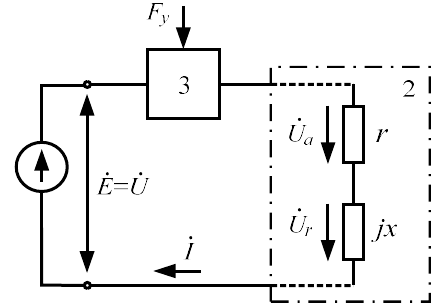
Figure 3. General block diagram of EM activation: 1, mains voltage supply; 2, EM stator winding; 3, controlled switching device; and F y , control signal, connecting or disconnecting the EM to the mains.